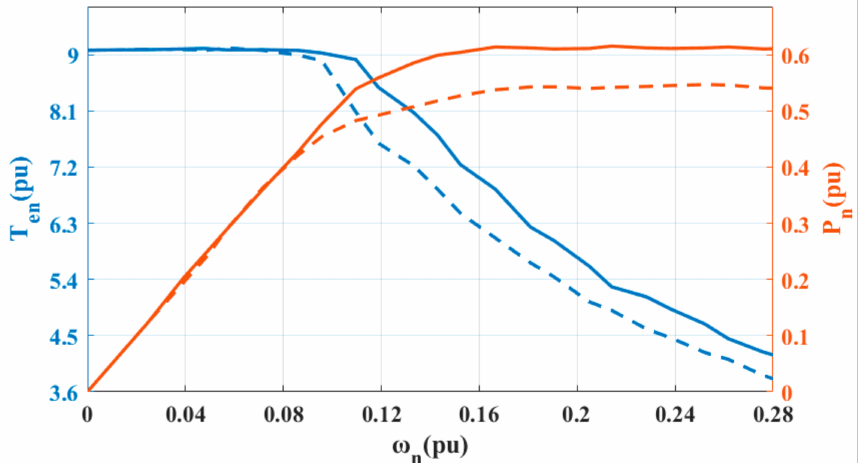
Figure 11. Torque-speed curve (blue), power-speed curve (red) of traditional topology (virtual line) and adding bidirectional DC/DC topology (solid